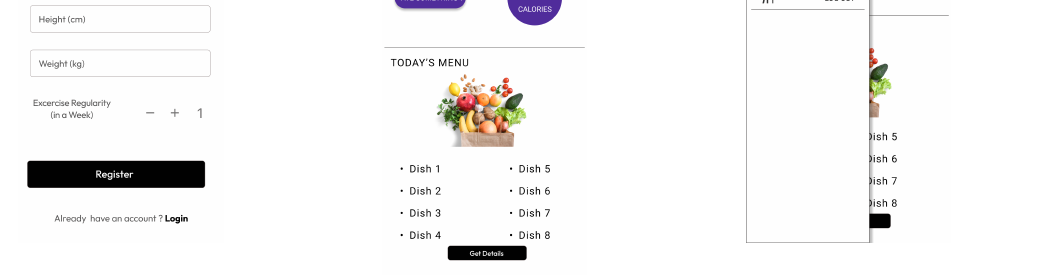
Figure 8. Navigation Screen